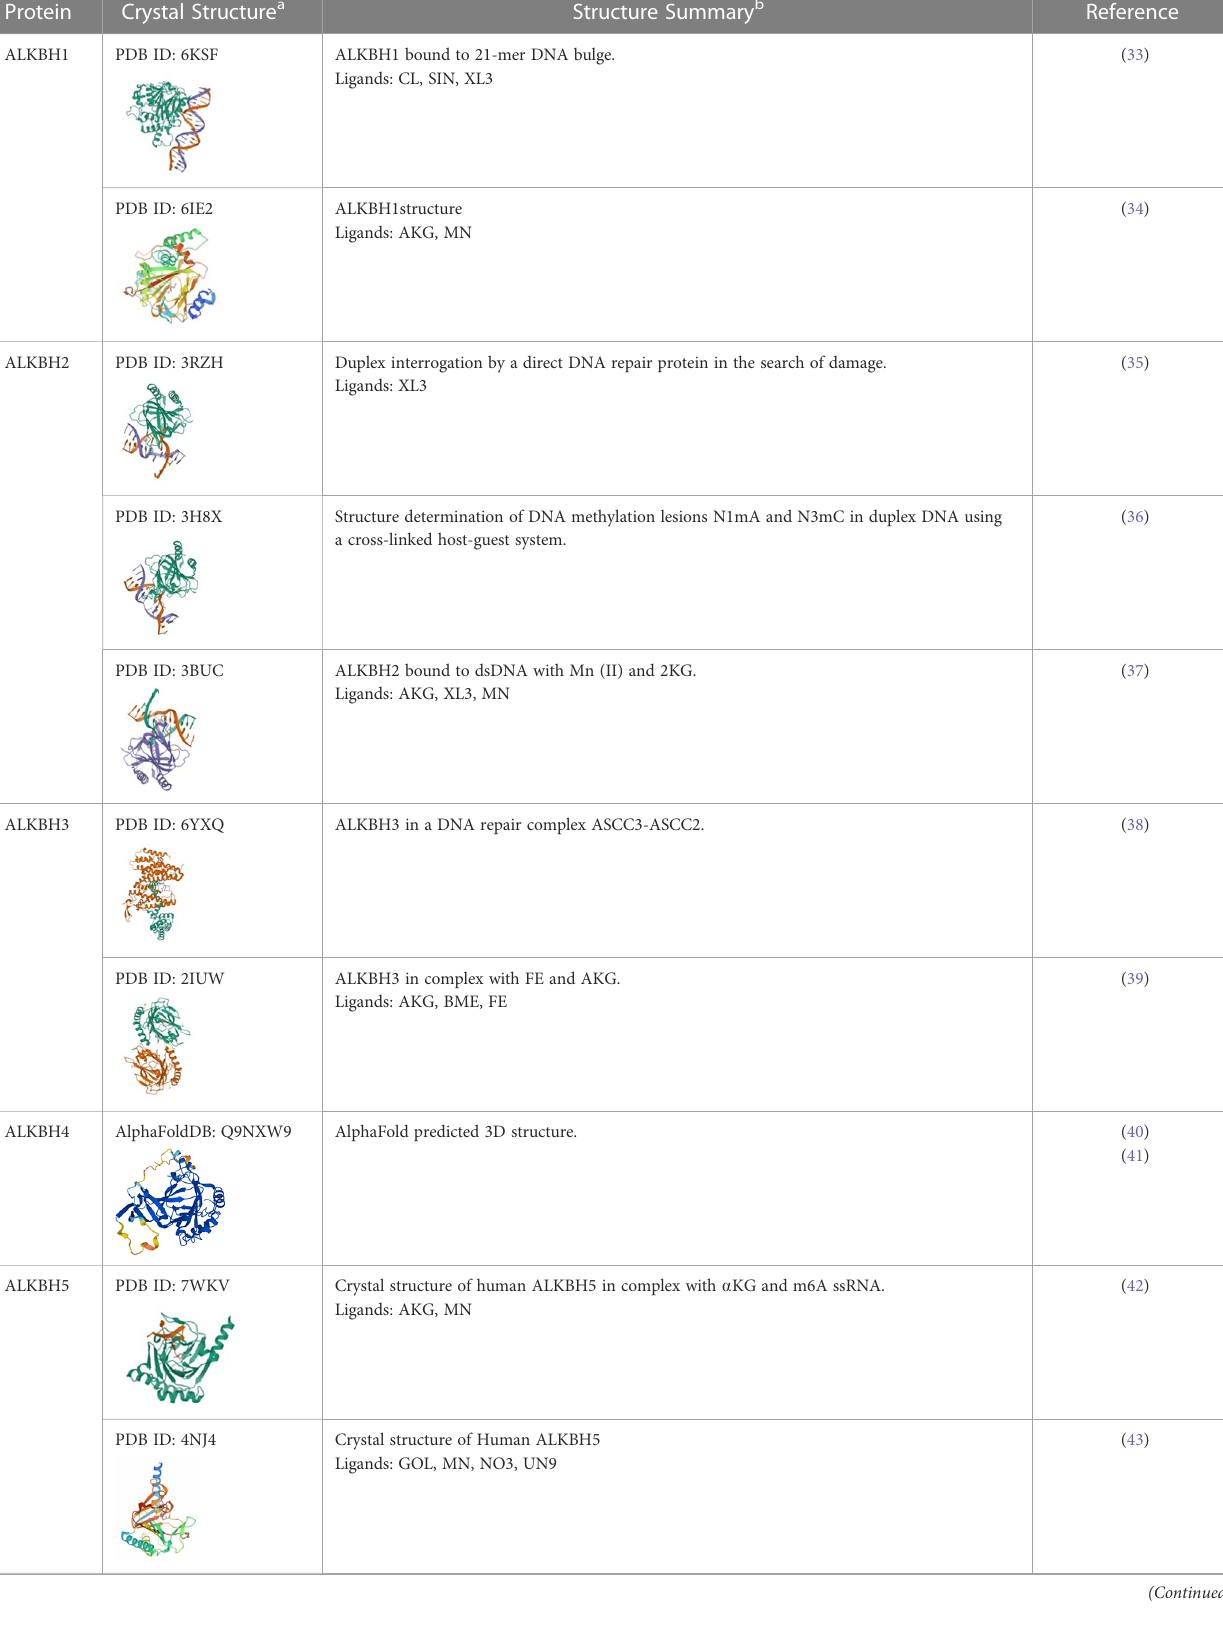
TABLE 1 The 3D structure of AlkB homologs and their ligands.